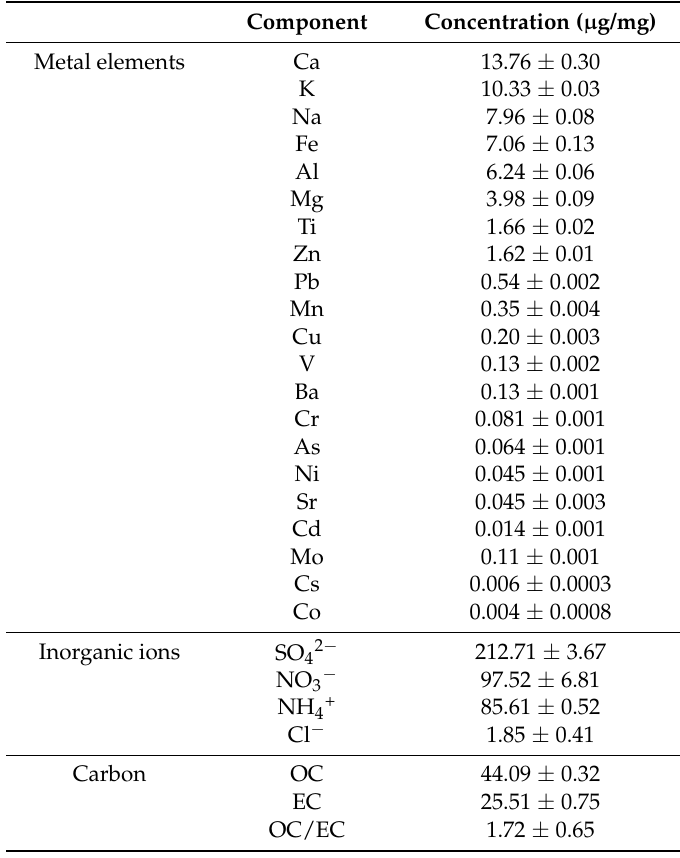
Table 1. Chemical composition analysis of the PM 2.5 samples.